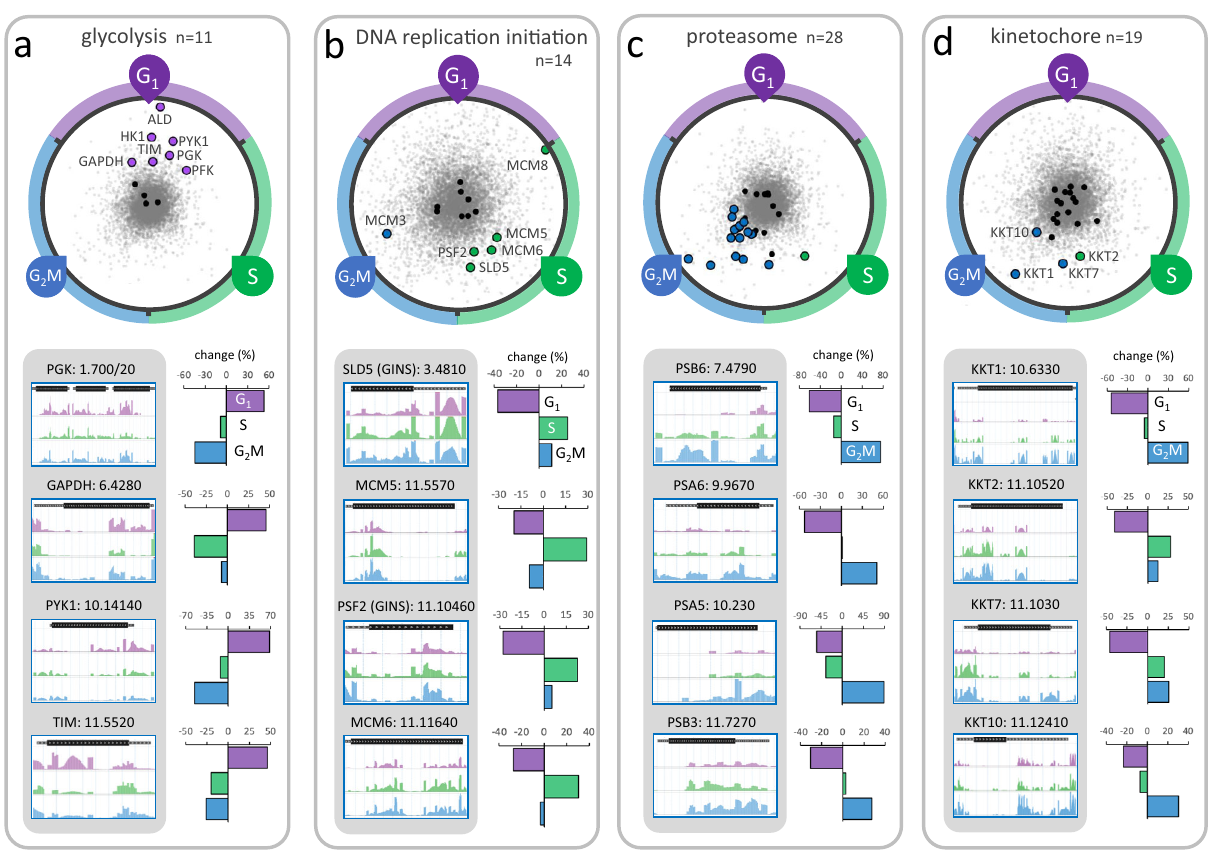
Fig. 5 | Protein complexes and pathways associated with G 1 , S phase and G 2 M defects. a The RadViz plot shows glycolytic enzyme knockdowns. Those that registered >25% overrepresented read-counts in the G 1 category are indicated. Blackdata-pointsindicateother genesfrom eachcohort. Grey data-pointsindicate all other genes. The read-mapping pro fi les and relative read-counts in the lower panel show example hits. b As in a but for DNA replication initiation factor